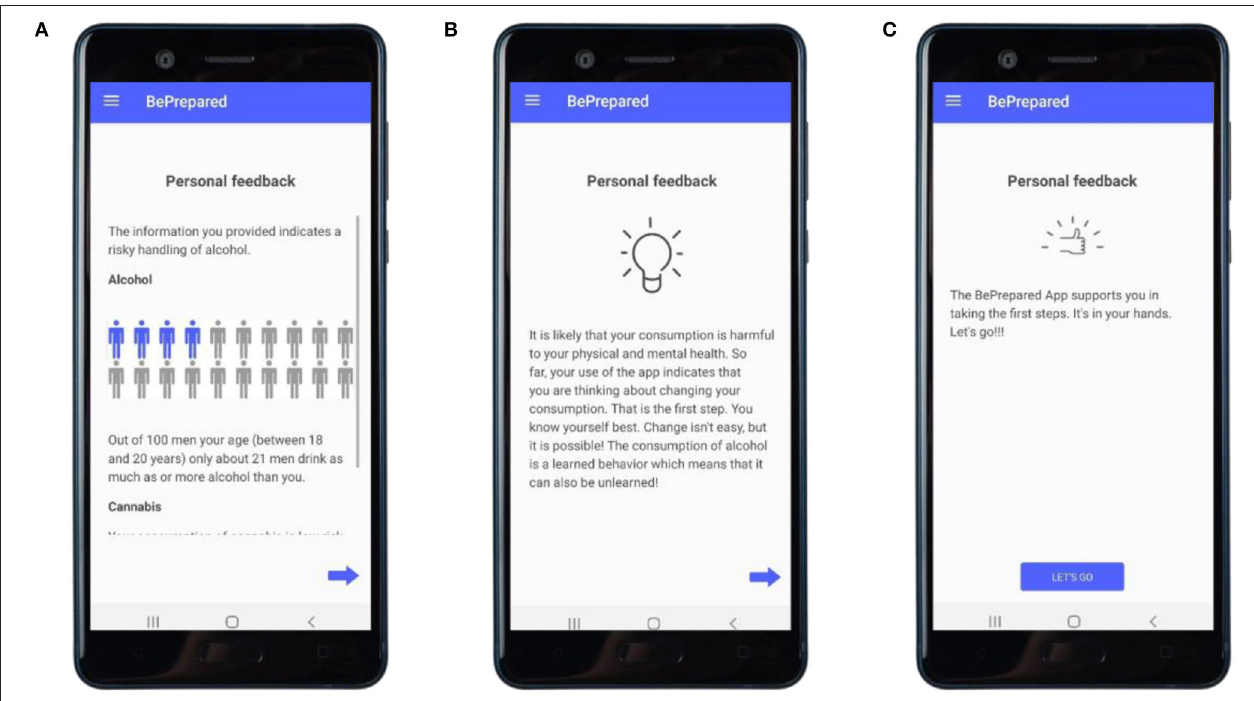
FIGURE 1 | Personalized feedback. (A) Feedback shown to a male user, aged 18–20, with problematic use of alcohol using a subjective normative approach; screen 2 out of 4. (B,C) Feedback based on the FRAMES-Model (51); screen 3 and 4 out of 4.